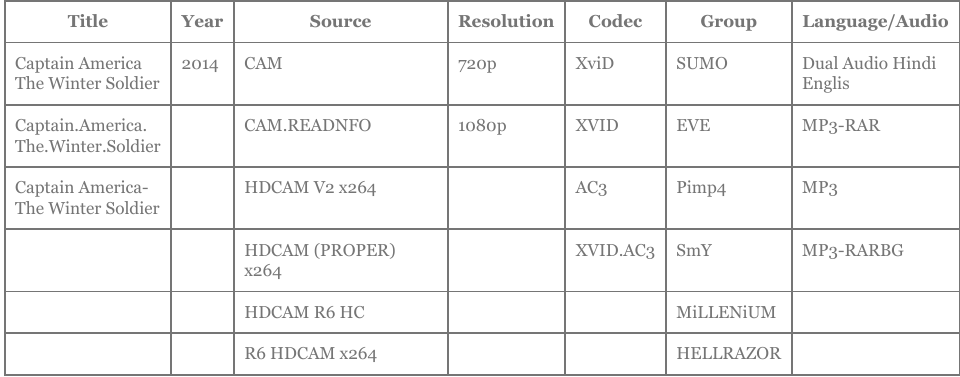
Table 1: Filenames and metadata describing torrent downloads of The Winter